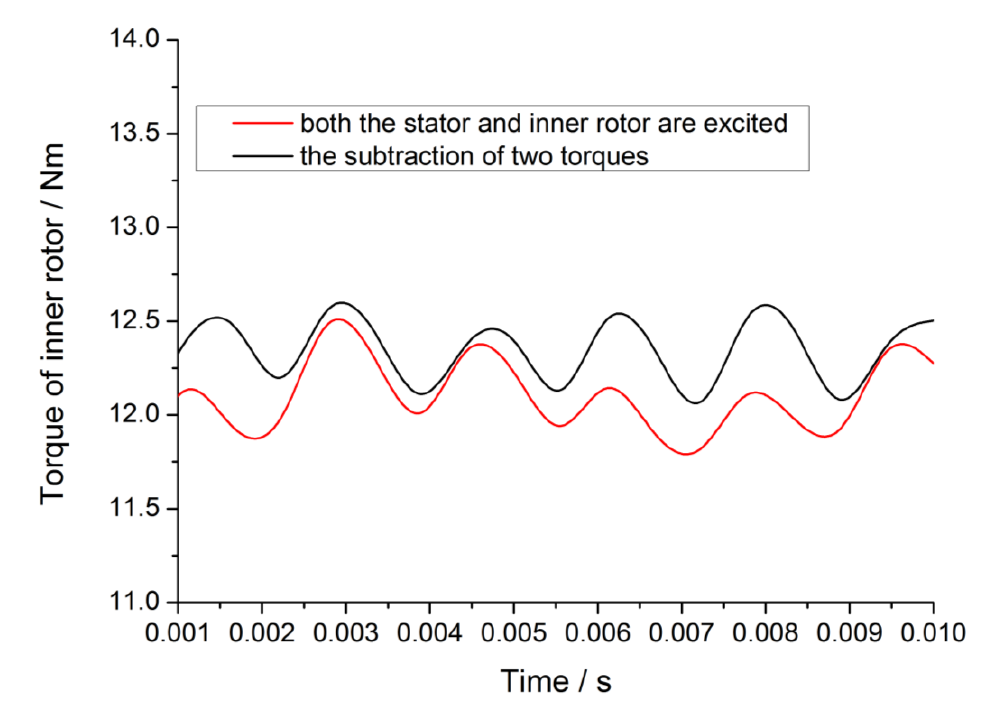
Figure 20. The torque waveforms comparison of the inner rotor in different